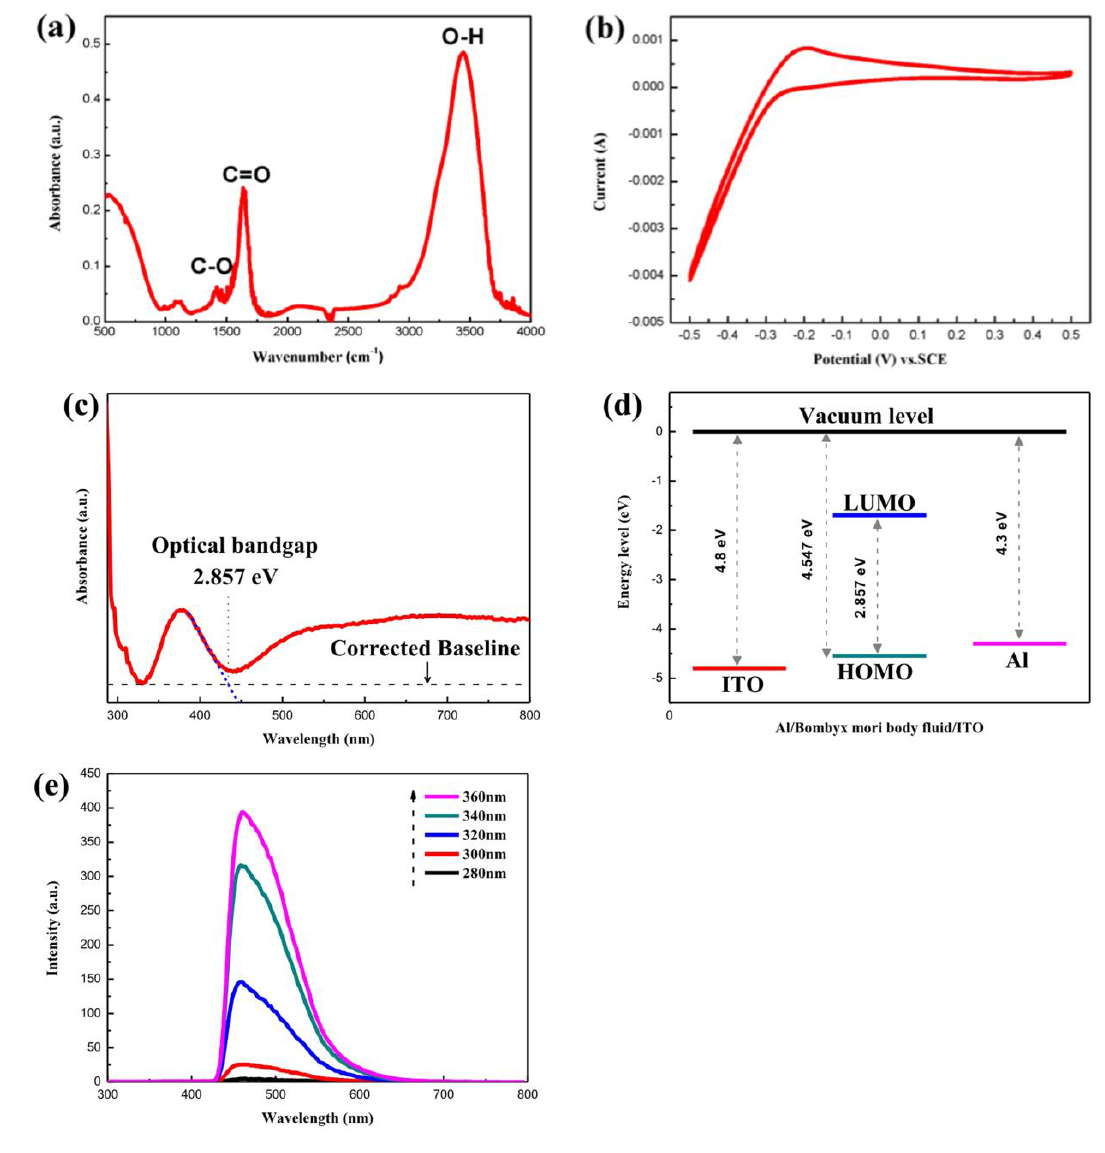
Figure 2. ( a ) Infrared spectrum of Bombyx mori body fluid; ( b ) Cyclic voltammetry curves and ( c ) Ultraviolet-visible absorption spectrum of the Bombyx mori body fluid film; ( d ) Energy level diagrams of the materials used in the Al / Bombyx mori body fluid film / ITO biomemristor; ( e ) Fluorescence emission spectra of the Bombyx mori body fluid film at different excitation wavelengths.